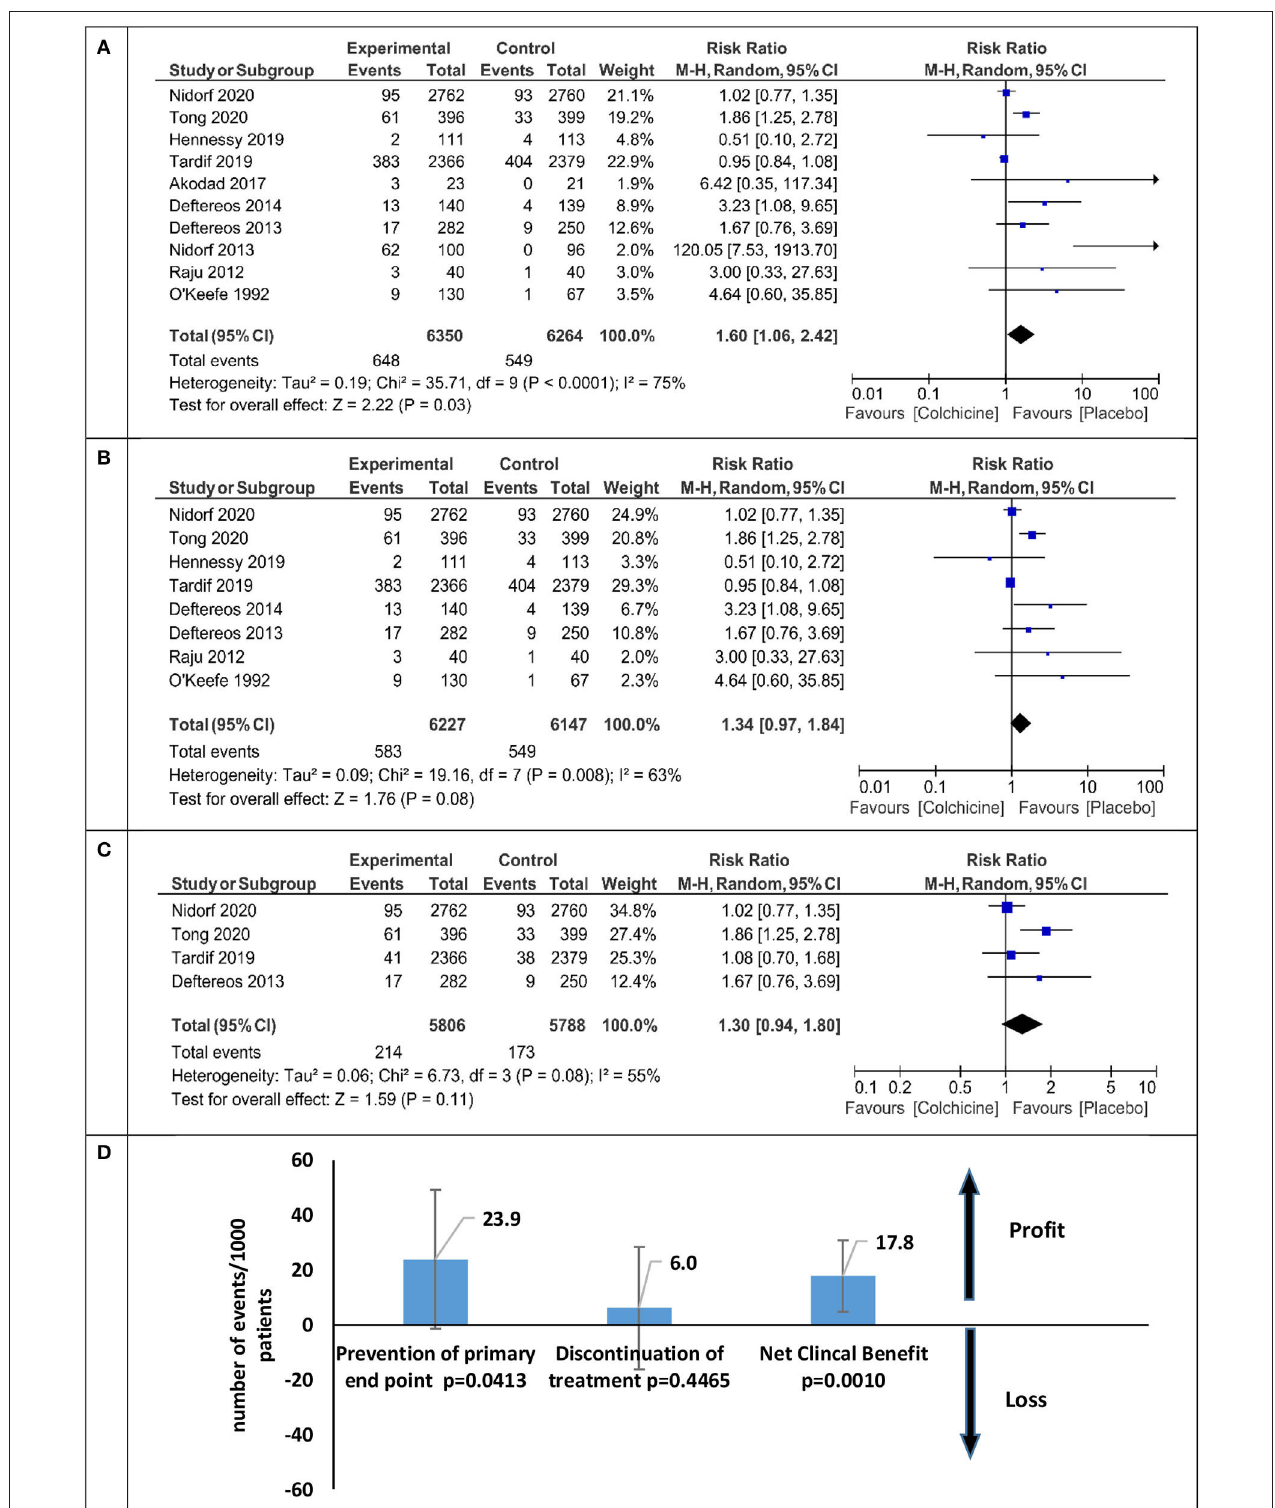
FIGURE 5 | Meta-analysis for the therapy discontinuation and net clinical benefit for all analyzed studies and sensitivity analysis. (A) Colchicine therapy discontinuation-all studies, (B) colchicine therapy discontinuation without PROBE studies, (C) colchicine therapy discontinuation sensitivity analysis, (D) net clinical benefit sensitivity